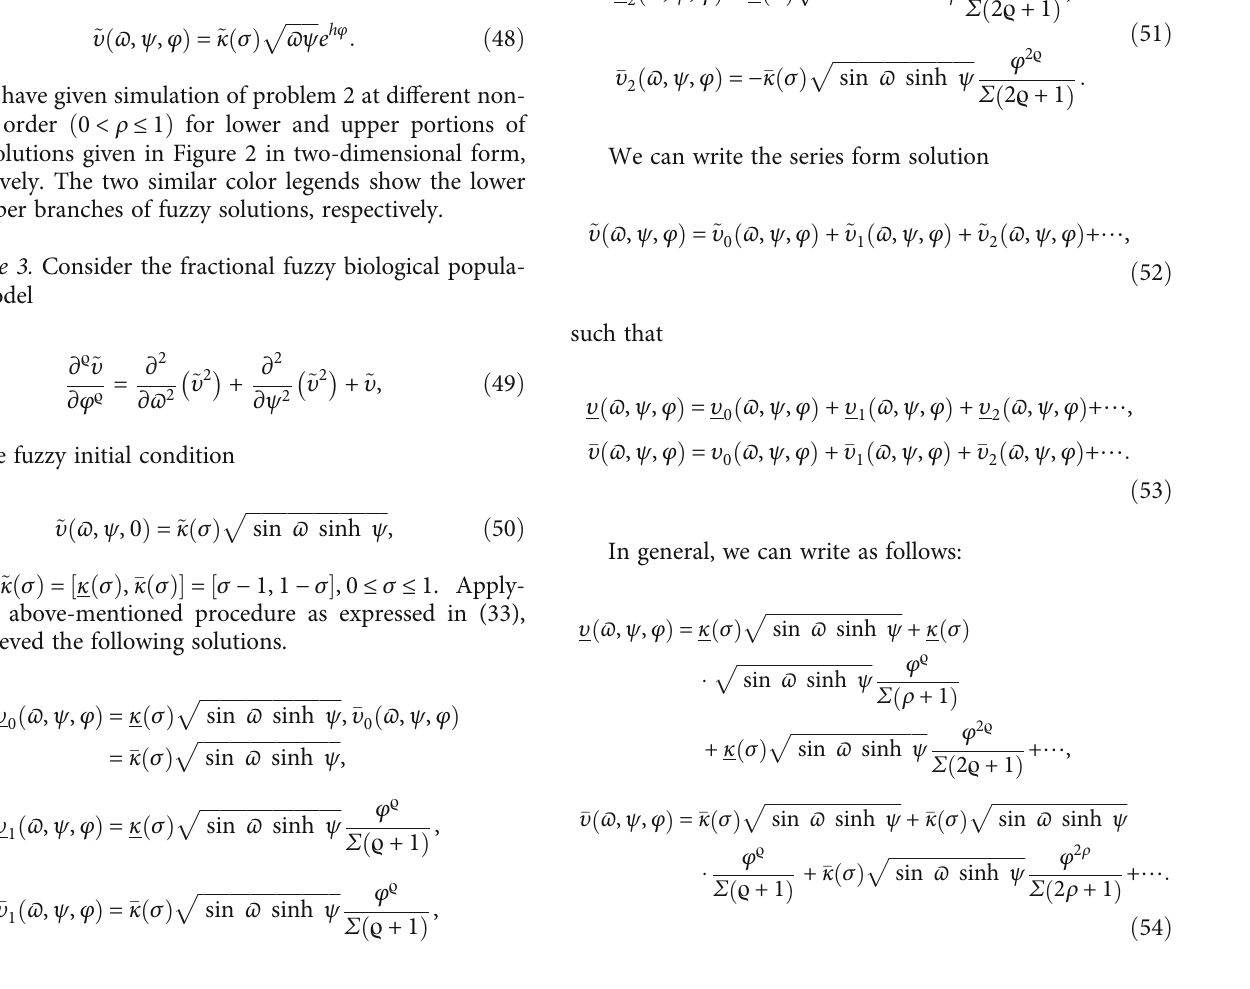
Figure 2: (a) A two-dimensional fuzzy upper and lower branch graph of an analytical series solution. (b) Di ff erent fractions of ϱ . The exact result